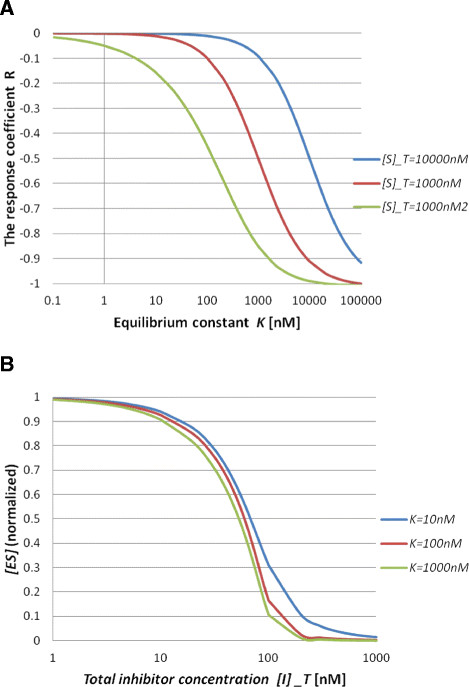
Behaviour of the steady state for a simple model. (A) Response coefficient R as a function of the equilibrium constant K for total substrate concentrations [S]T = 100nM, 1000nM and 10000nM. (B) Complex concentration [ES] as a function of the total inhibitor concentration [I]T for equilibrium constant values K = 10nM, 100nM and 1000nM.